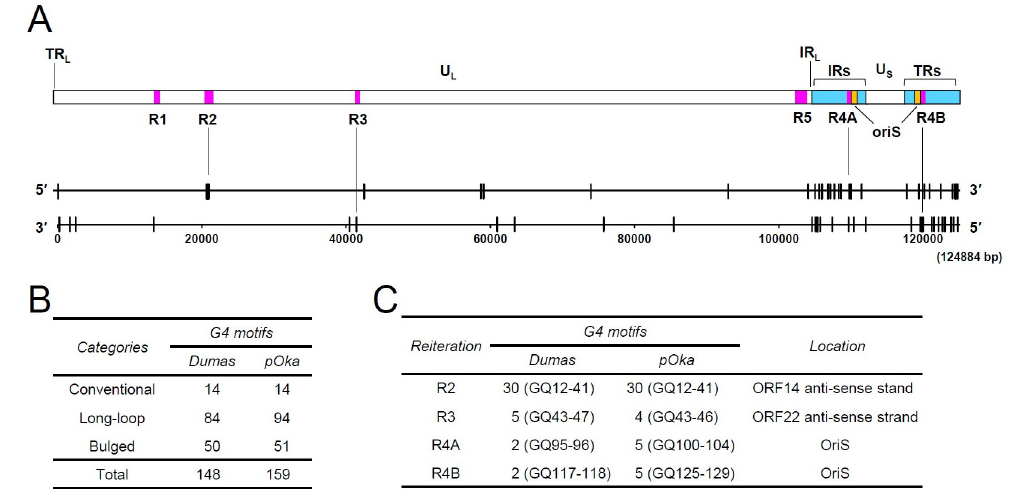
Fig 1. Distribution of putative G4 motifs in the VZV genome. (A) The locations for the predicted 148 G4 motifs (denoted as GQ1 to GQ148) in the Dumas strain are indicated as short vertical lines on the top and bottom sequences of the viral genome. The locations of the terminal repeat long (TR L ), unique long (U L ), internal repeat long (IR L ), internal repeat short (IR S ), unique short (U S ), terminal repeat short (TR S ), oriS and reiteration sequences (R1, R2, R3, R4A, R4B, and R5) are also indicated. (B and C) The numbers of predicted G4-motifs in different categories (B) and in different reiteration sequence regions (C) in Dumas and pOka strains are